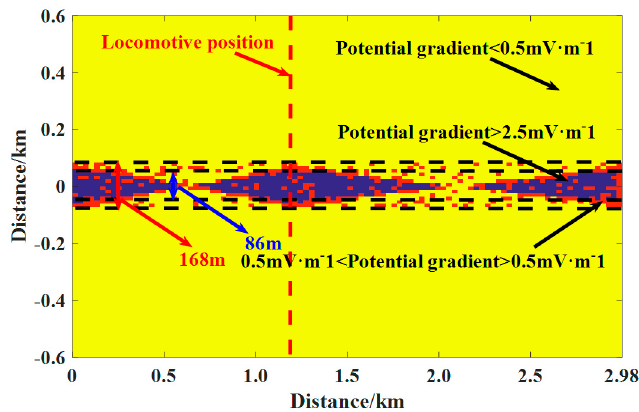
Figure 15. Stray current corrosion scope simulated by COMSOL 5.2.